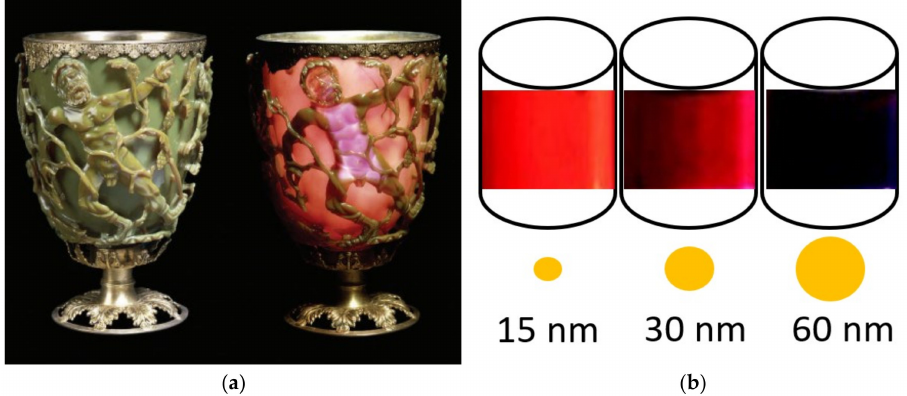
Figure 1. ( a ) The Lycurgus Cup (British Museum; AD fourth century, Room 41, i.d. 1958,1202.1). This Roman cup is made of ruby glass. When viewed in reflected light, for example in daylight, it appears green ( left ). However, when a light is shone into the cup and transmitted through the glass, it appears red ( right ). Images reproduced, with permission from [5]. © The Trustees of the British Museum. Image shared under a Creative Commons Attribution-Non Commercial-ShareAlike 4.0 International (CC BY-NC-SA 4.0) license. ( b ) Colloidal suspensions of gold nanoparticles in water. The nanoparticle diameters are indicated on the container (Image adapted from Celso de Mello Doneg á , Nanoparticles workhorses of Nanoscience, Springer, 2014, courtesy F.H. Reincke, Utrecht University